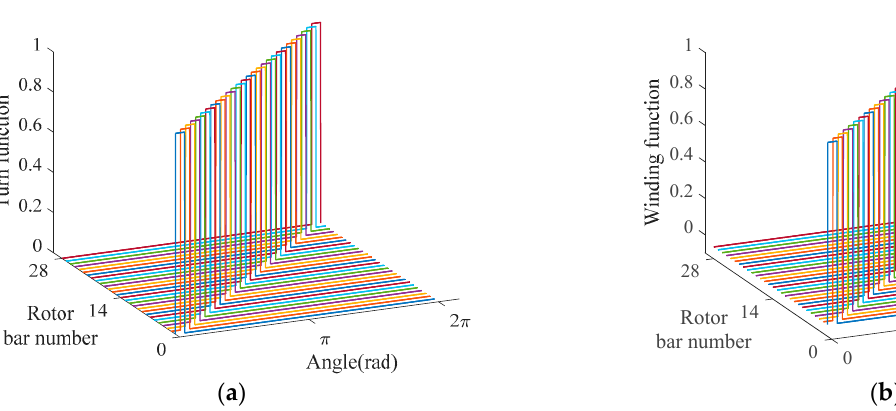
Figure 6. TFs and WFs of the rotor loops. ( a ) TFs; ( b ) WFs. The self and mutual inductance of the stator and rotor can be calculated from Equa- tion (8). Figure 7 shows the mutual inductance curves of stator phase a and rotor bar 1 in the rotor angular range [ ] 0,3 π and their differentials, which allow us to determine the time-varying characteristics of the inductor during the motor operation. As shown in Fig- ure 8, when the air gap is inhomogeneous due to static or dynamic eccentricity, etc., the mutual inductance curve will be distorted with respect to the eccentricity. This phenome- non of air gap length distribution affecting inductance variation can be explained by the air gap inverse function included in Equation (8). ( a ) ( b )